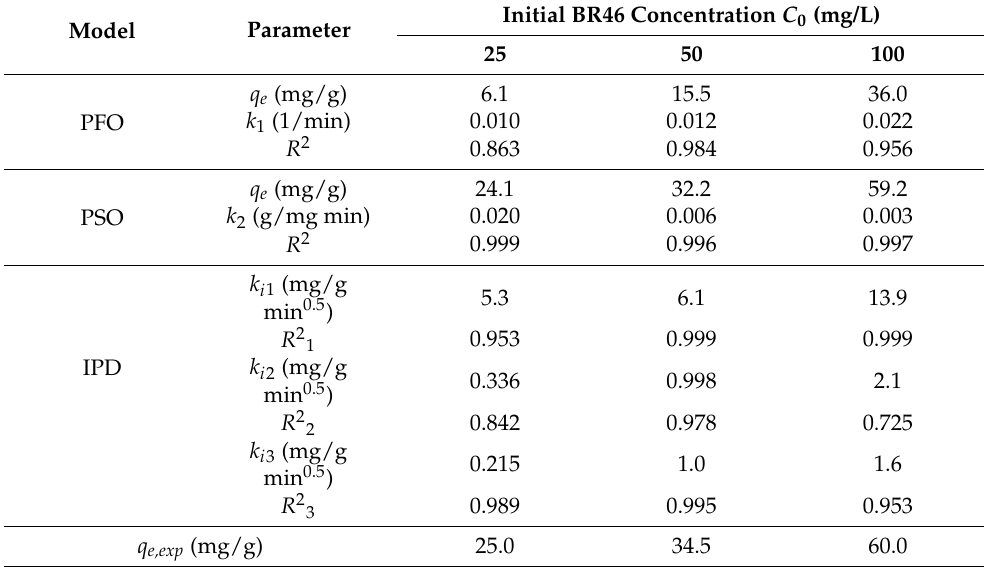
Table 3. Kinetic parameters calculated from the PFO, PSO and IP models for BR46 sorption from 25–100 mg/L solutions on C/SiO 2 .